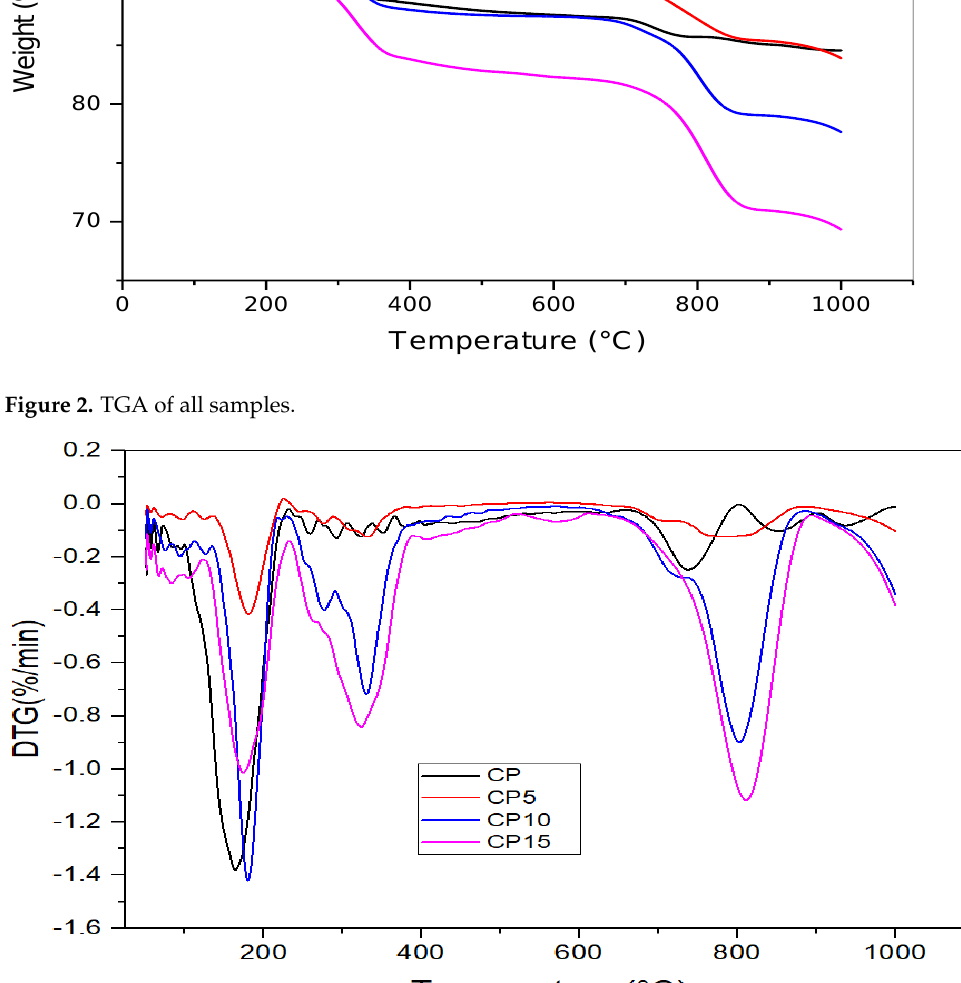
Figure 3. DTG of all